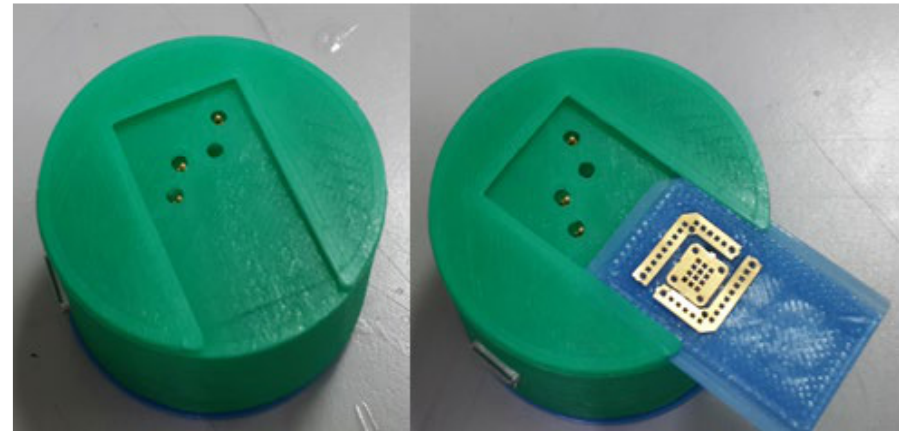
Figure 7. Assembled device and microneedle sensor. The test piece can be changed more rapidly using the spring mechanism.